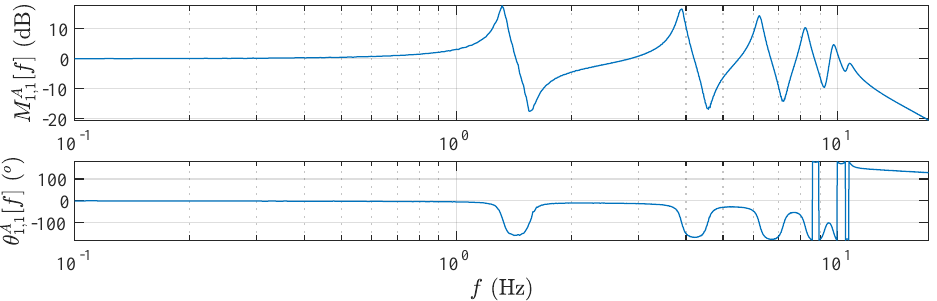
Figure 17. Shear frame: estimated (Welch’s method with Hanning window, N FFT = 2 11 , 50% overlap) absolute vibration acceleration FRF of the first story at reference temperature.